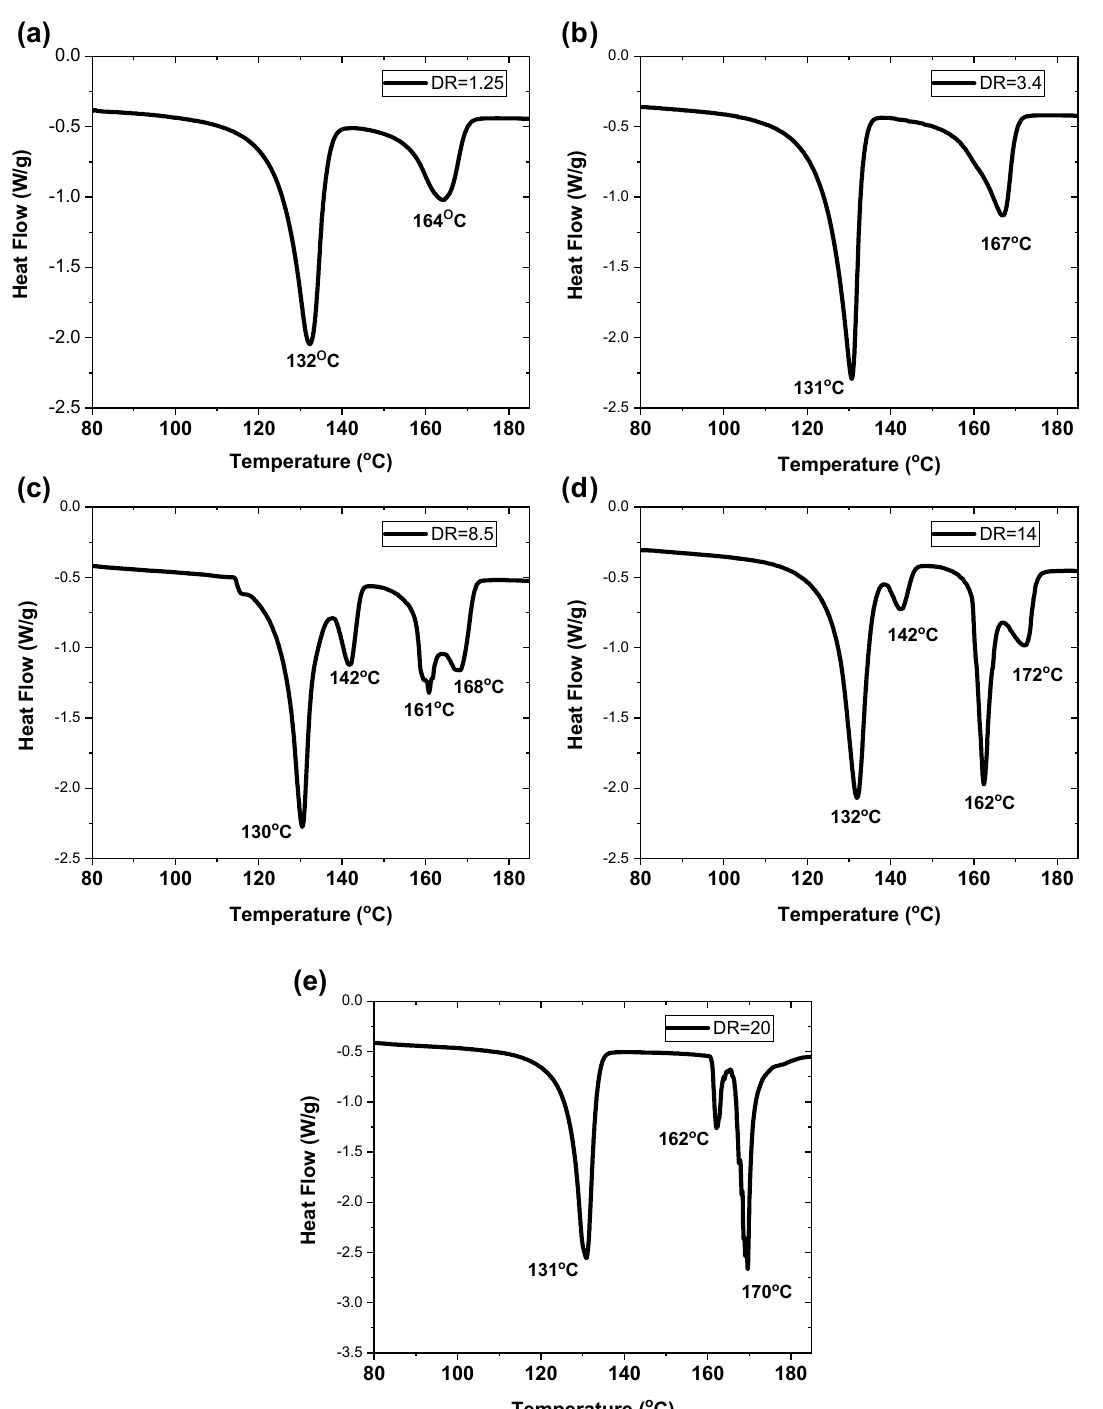
Figure 8. DSC thermographs of oriented 50/50 PP/HDPE tapes at draw ratios of ( a ) 1.25; ( b ) 3.4; ( c ) 8.5; ( d ) 14; and ( e ) 20.